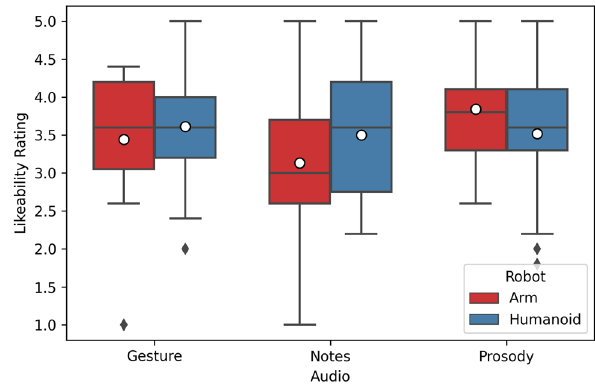
Figure 8: Box plot of perceived Intelligence, comparing humanoid and arm across audio types. White dot indicates mean, middle line is median, and black dots are outliers.